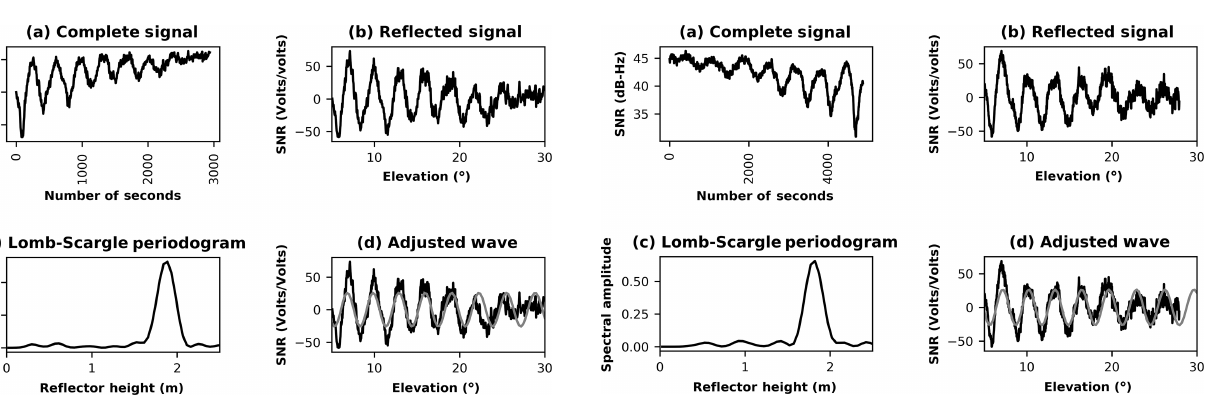
Figure 9. GALILEO satellite no. 21 observed with the geodetic an- tenna. SNR data in volts (a) , SNR data with the direct signal re- moved (b) , Lomb–Scargle periodogram for the SNR reflected sig- nal (c) , and SNR reflected signal with the adjusted wave (d) .